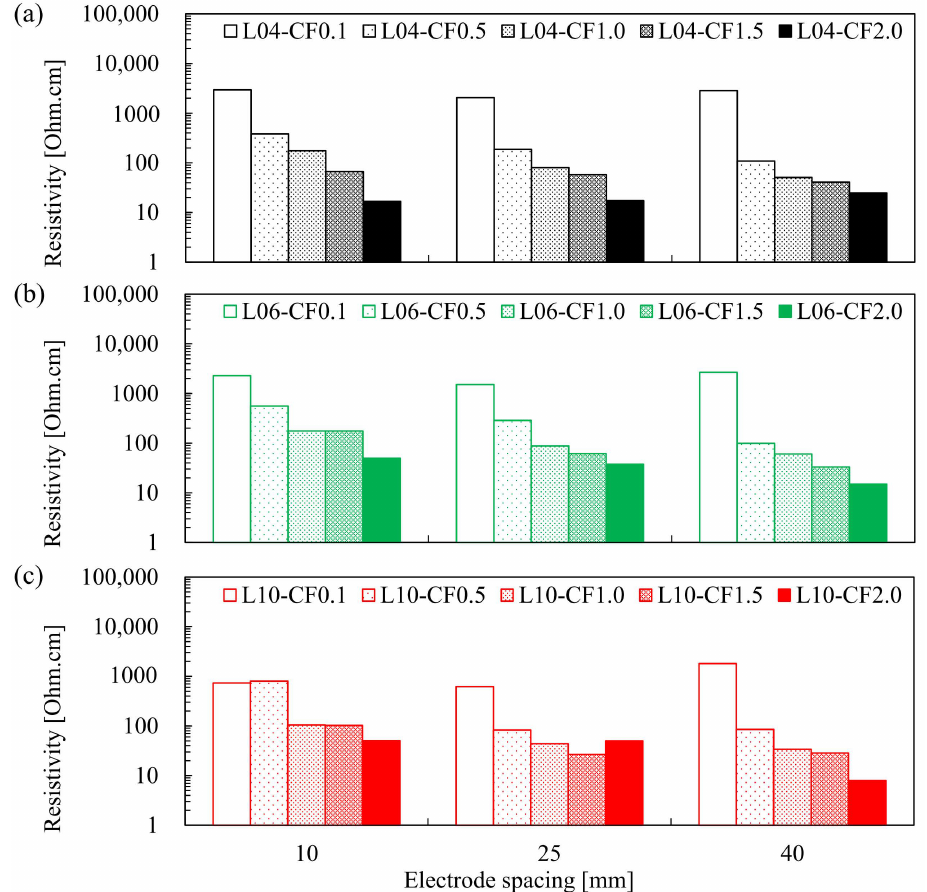
Figure 4. Resistivity of cement composites after 28 days of curing measured through the two-probe configuration for di ff erent electrode spacings and carbon fiber (CF) lengths of ( a ) 4 mm (L04), ( b ) 6 mm (L06), and ( c ) 10 mm (L10). CF0.1–2.0 indicate the CF content (0.1–2%)